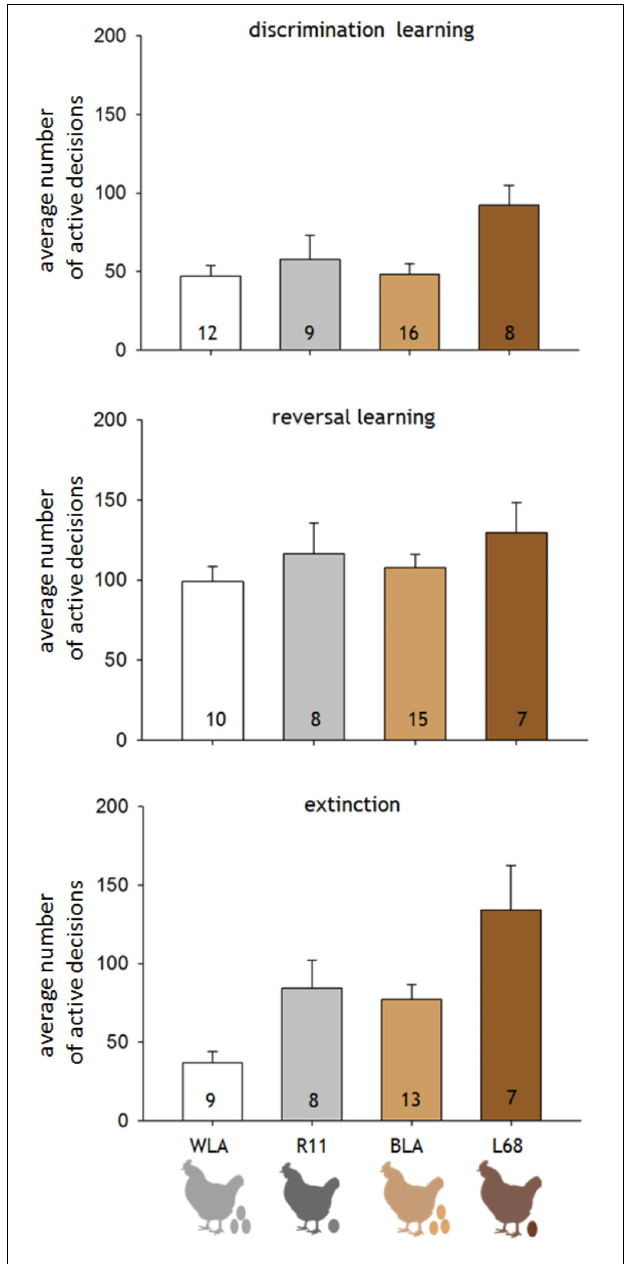
FIGURE 3 | Averaged number of active decisions ( ± SD) needed by hens of the different lines, WLA, R11, BLA, and L68, to fulfill the learning criteria of each phase. The number within each column represents the number of hens, which participated in that phase ( n ). Discrimination learning was significant affected by productivity (LM: factor productivity: F 1 , 41 = 69.63, p = 0.011; factor phylogeny: F 1 , 41 = 2.023, p = 1.63; interaction productivity ∗ phylogeny: F 1 , 41 = 2.792, p = 0.102). Whereas reversal learning was more difficult for all hens, independent of their phylogenetic background or productivity level (LM: factor productivity: F 1 , 36 = 1.924, p = 0.174; factor phylogeny: F 1 , 36 = 0.641, p = 0.423; interaction productivity ∗ phylogeny: F 1 , 36 = 0.028, p = 0.867). The average active decisions needed for the extinction level were significantly affected by phylogenetic origin and productivity (LM: factor productivity: F 1 , 33 = 9.543, p = 0.004; factor phylogeny: F 1 , 33 = 8.588, p = 0.006; interaction productivity ∗ phylogeny: F 1 , 33 = 0.09, p =